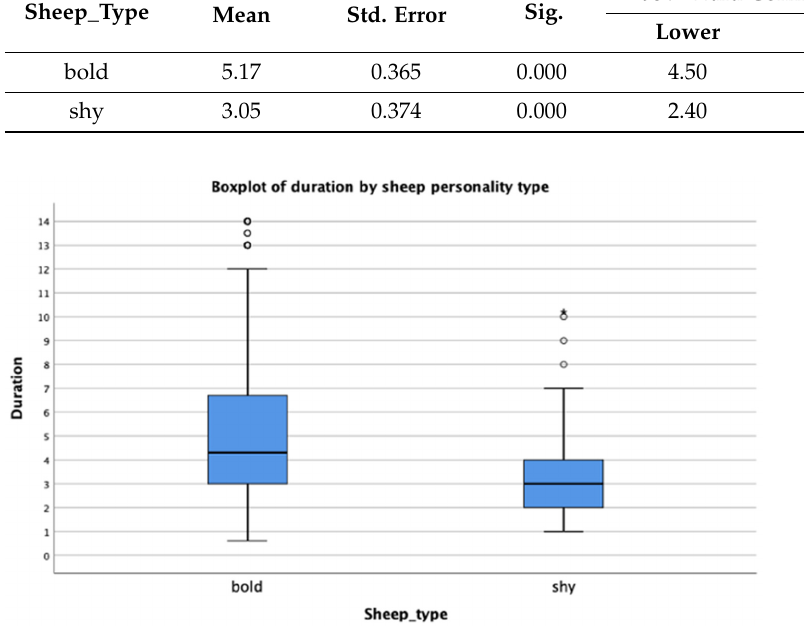
Figure 3. Time duration (in seconds) that animals need to respond to sound cues, based on sheep personality type. The vertical lines indicate the range (minimum and maximum time in seconds), upper and lower quartiles with median (blue boxes), and outliers (represented by